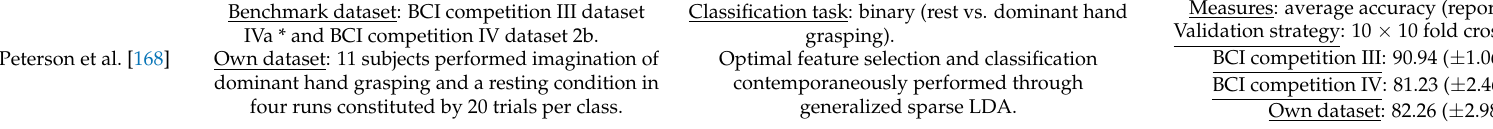
2. Feature extraction algorithm combining semisupervised joint mutual information with general discriminate analysis (SJGDA) to reduce the dimension of vectors in the Riemannian tangent plane and classification with KNN.